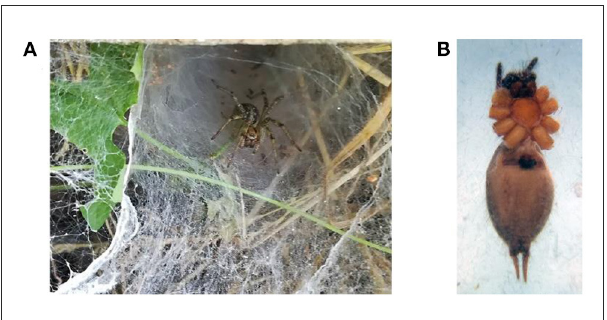
FIGURE1 Agelena labyrinthica species. (A) The Agelena labyrinthica spider on the net. (B) The epigyne of female